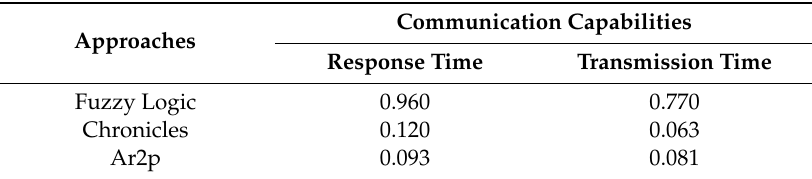
Table 17. Results for the Communication